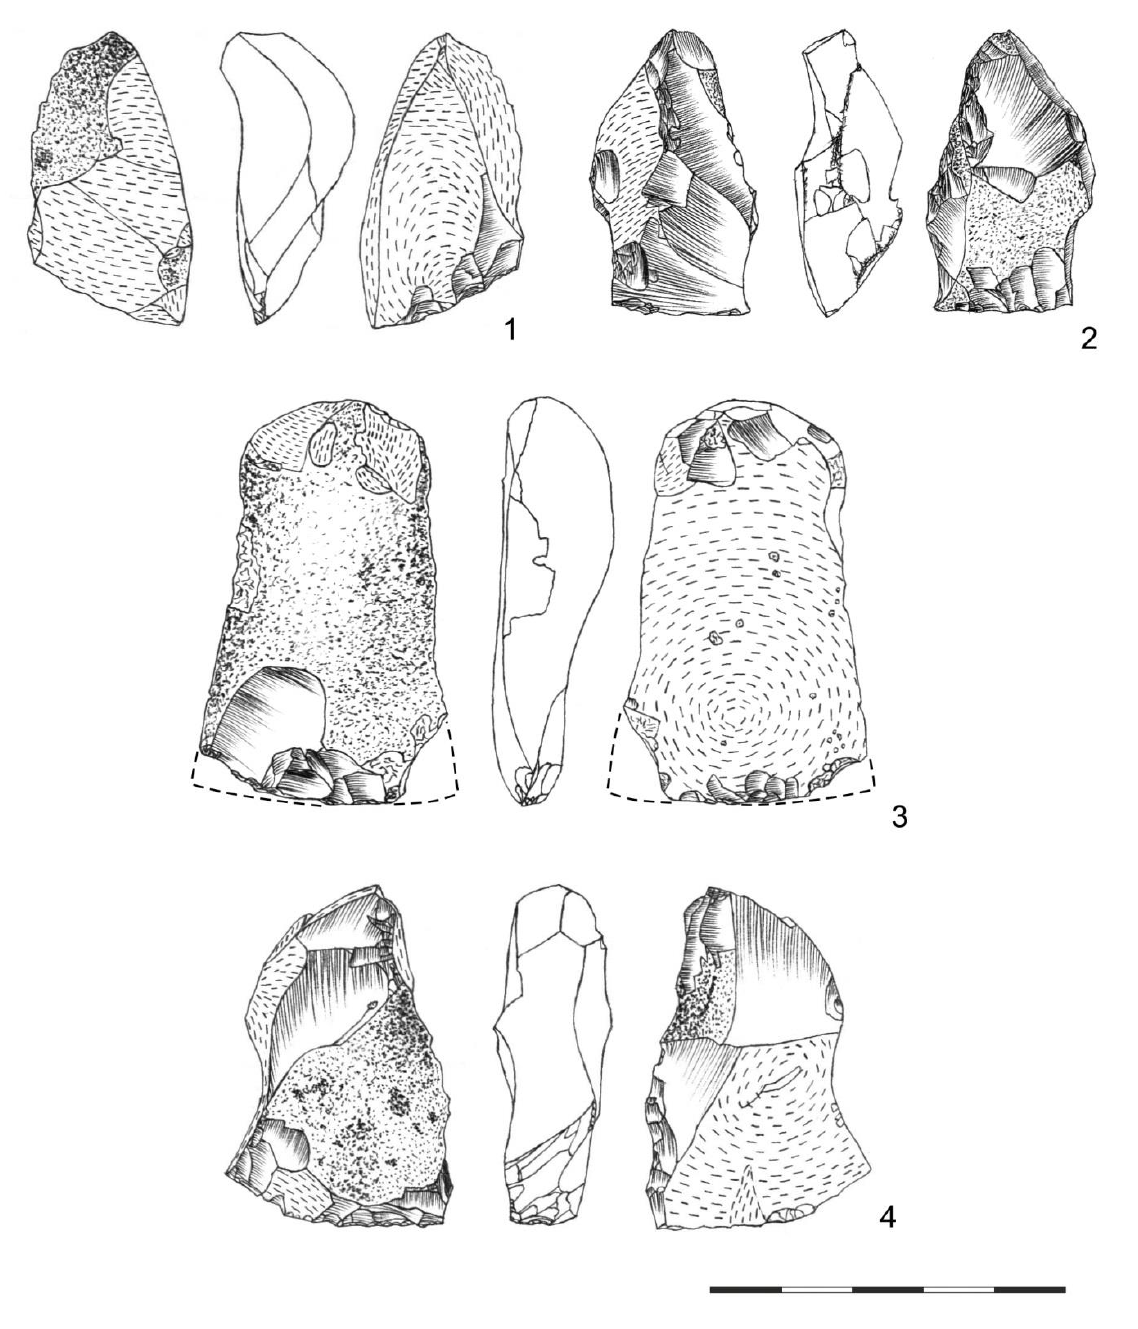
Figure 2. Core tools. 1 – semi-products of core axe blade (?); 2-4 – core axe blades. Drawn by P.